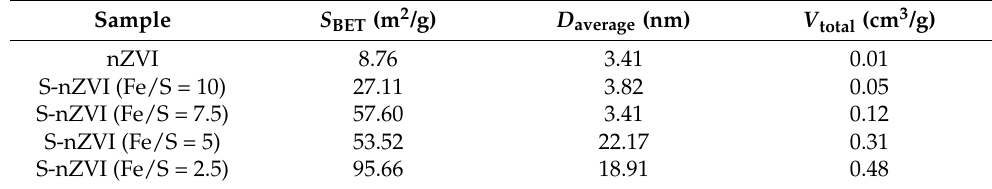
Table 1. Pore-structure parameters of nZVI and S-nZVI materials with different Fe/S ratios. Sample